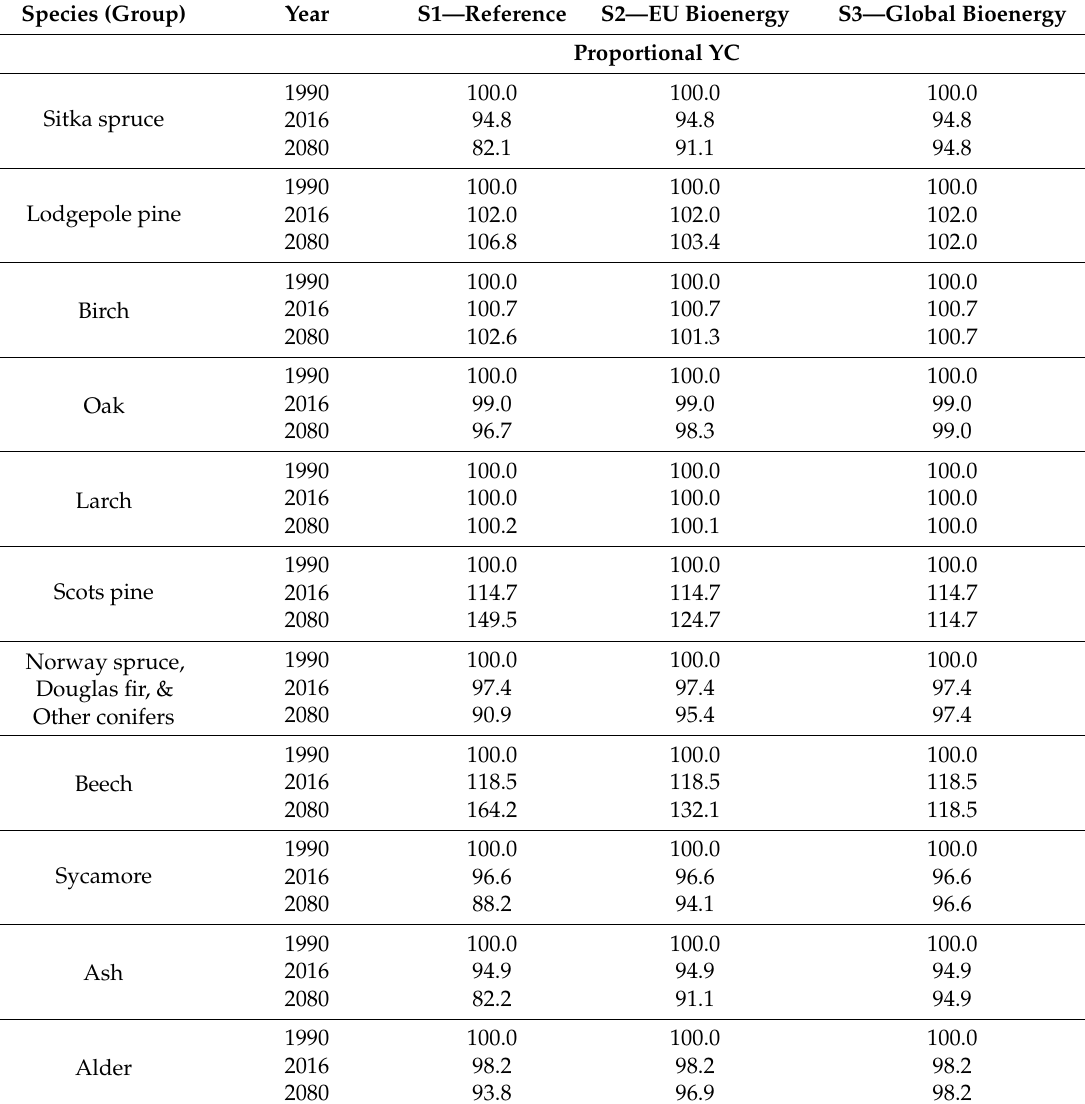
Table 6. Proportional YC for 11 species, for three future scenarios in response to CC. Proportional YC of 100% in 2080 means that the YC is unchanged, a value smaller than 100% means YC decreases, a value higher than 100% means YC increases. The proportional YC change was interpolated between 1990 and